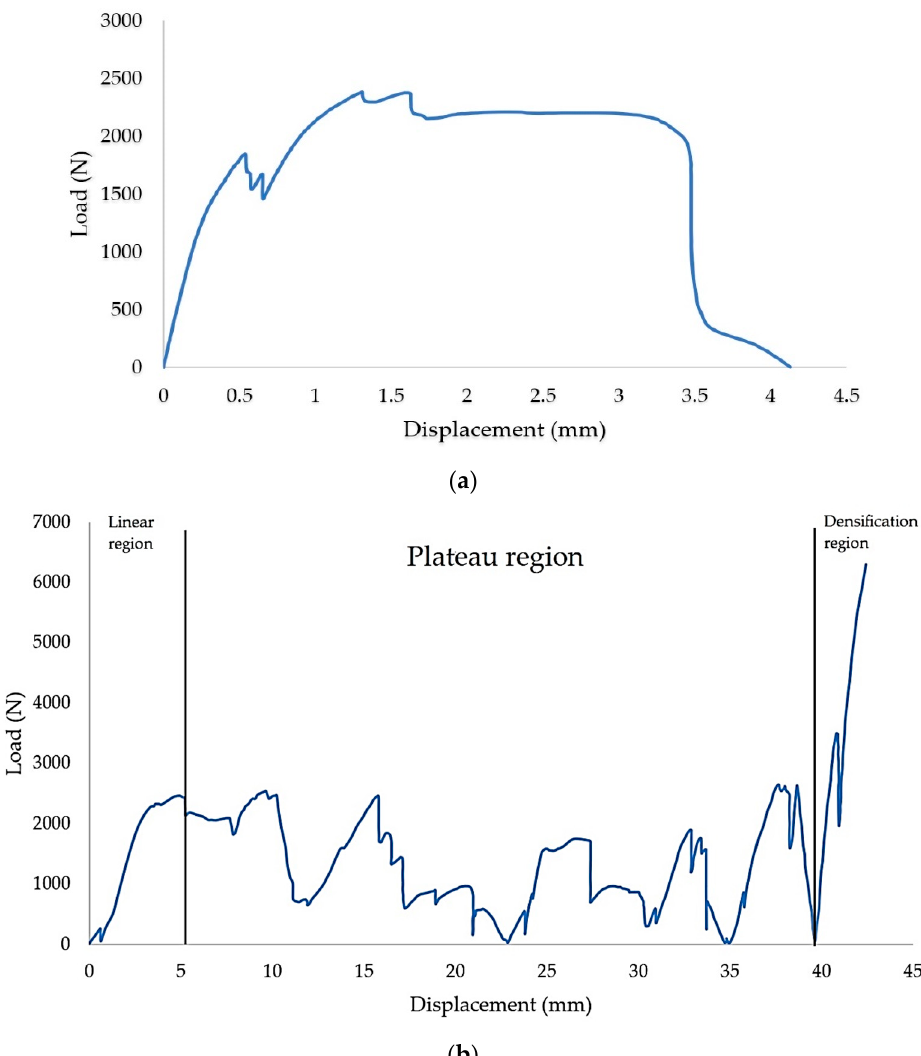
Figure 7. Load-displacement curve of a sample with a 25 mm cell size, 2 mm wall thickness, showing the ( a ) initial stage and ( b ) second stage of the failure.